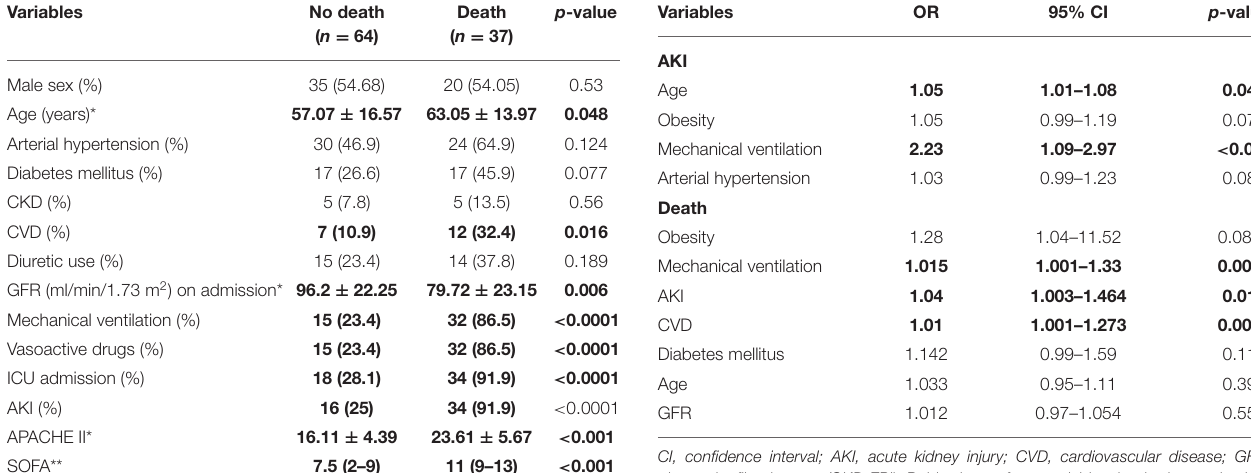
TABLE 2 | Clinical and laboratory characteristics of hospitalized patients according to outcome. Variables